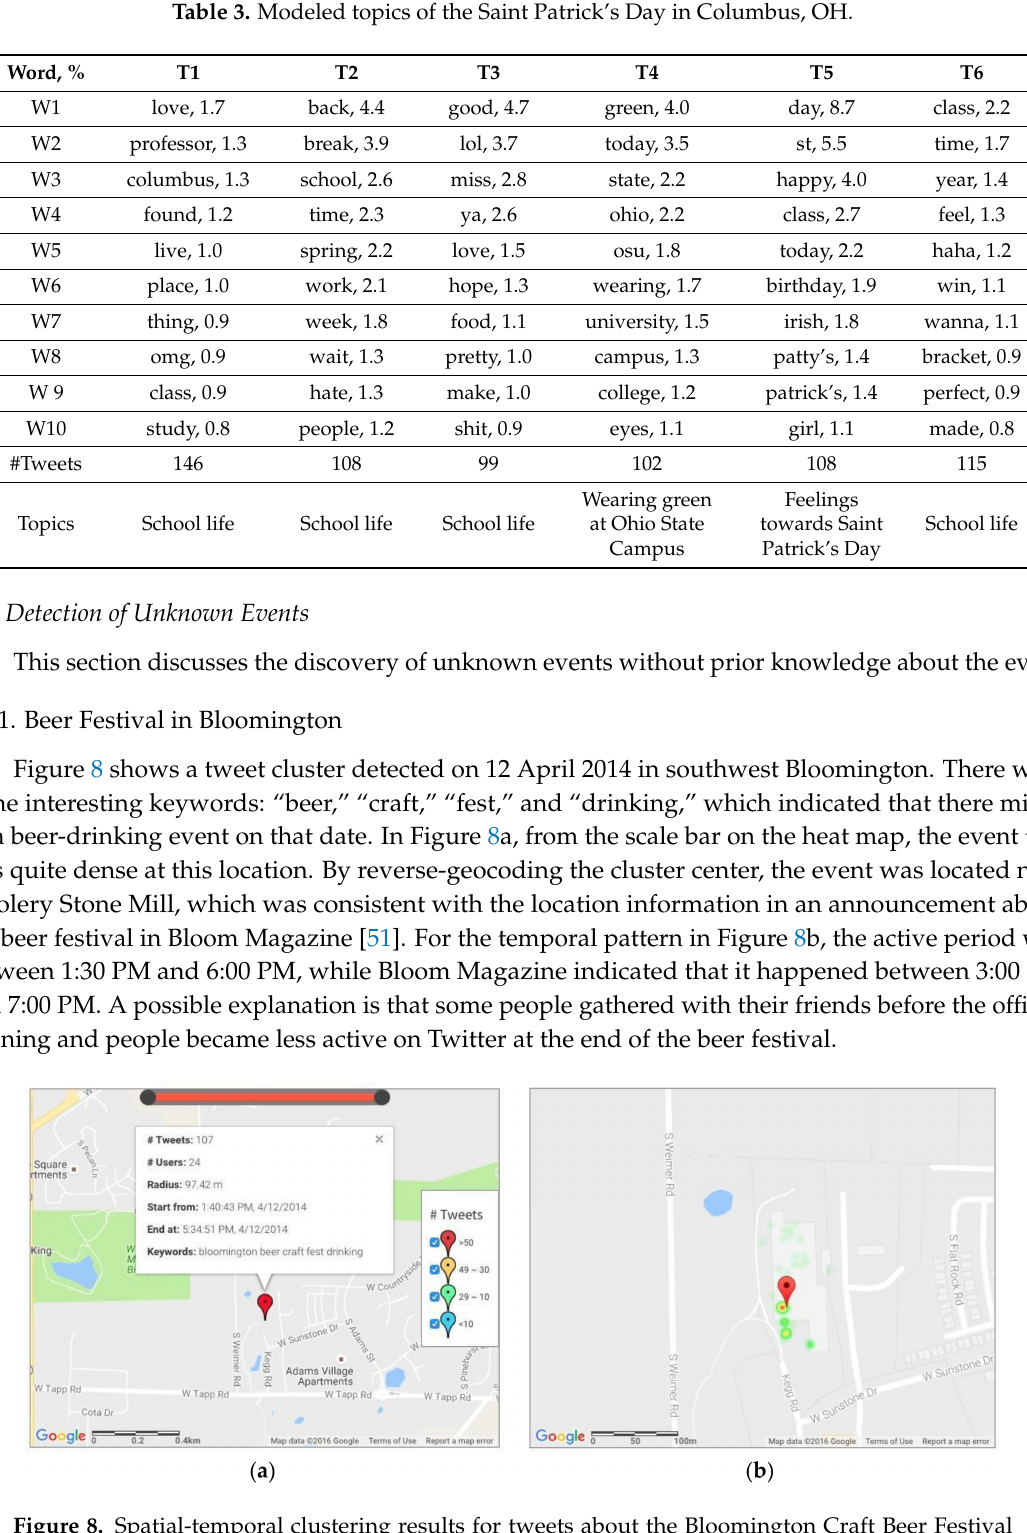
Figure 8. Spatial-temporal clustering results for tweets about the Bloomington Craft Beer Festival on 12 April 2014: ( a ) the most significant cluster; and ( b ) distribution of the tweets in the most significant